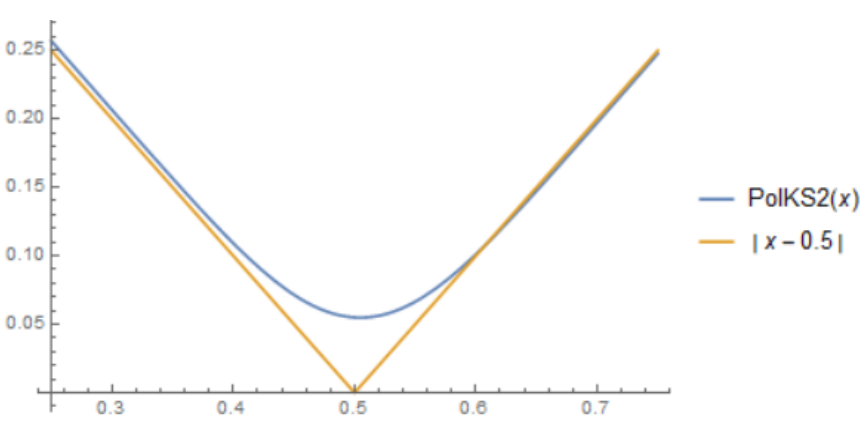
Figure 3. α = 0.1, β = 0.65, m = 50 iterations.